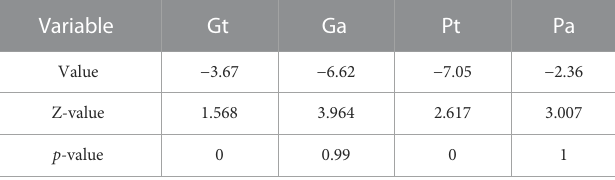
TABLE 6 Results of Westerlund (2007) co-integration